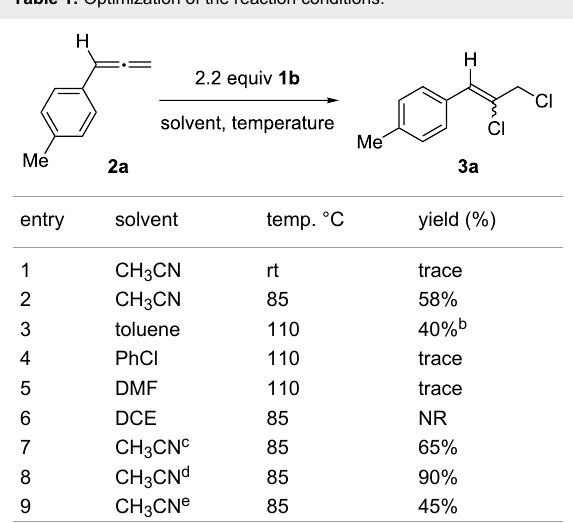
Table 1: Optimization of the reaction conditions.